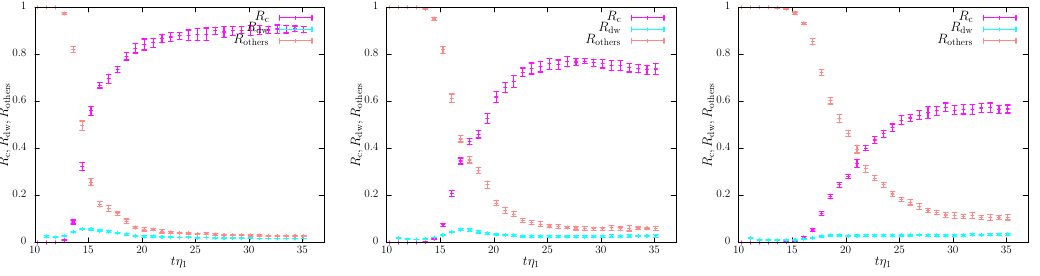
Figure 15 . The time-evolution of R c; dw ; others for various q 2 . We take q 2 = 2 ; 3 ; 4 from left to right. The rightmost panel is the same with (cid:12)gure